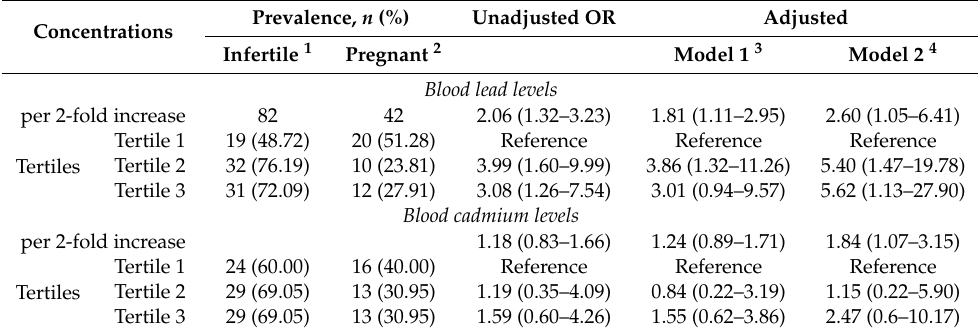
Figure 1. Number of events by blood lead (a) and blood cadmium (b) tertiles. Lead T1: Tertile 1 (0.11–0.38 µg/dL), T2: Tertile 2 (0.41–0.62 µg/dL), T3: Tertile 3 (0.63–5.37 µg/dL). Cadmium T1: Tertile 1 (0.07–0.19 µg/L), T2: Tertile 2 (0.20–0.33 µg/L), T3: Tertile 3 (0.34–5.14 µg/L). Table 2. Odds ratio (95% CI) of being infertile associated with blood lead and blood cadmium levels.